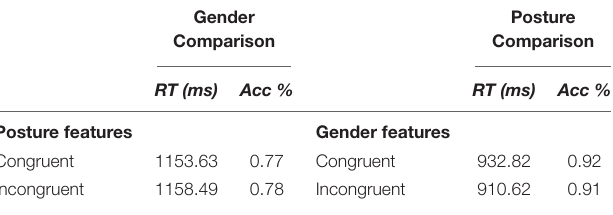
Gender Posture Comparison